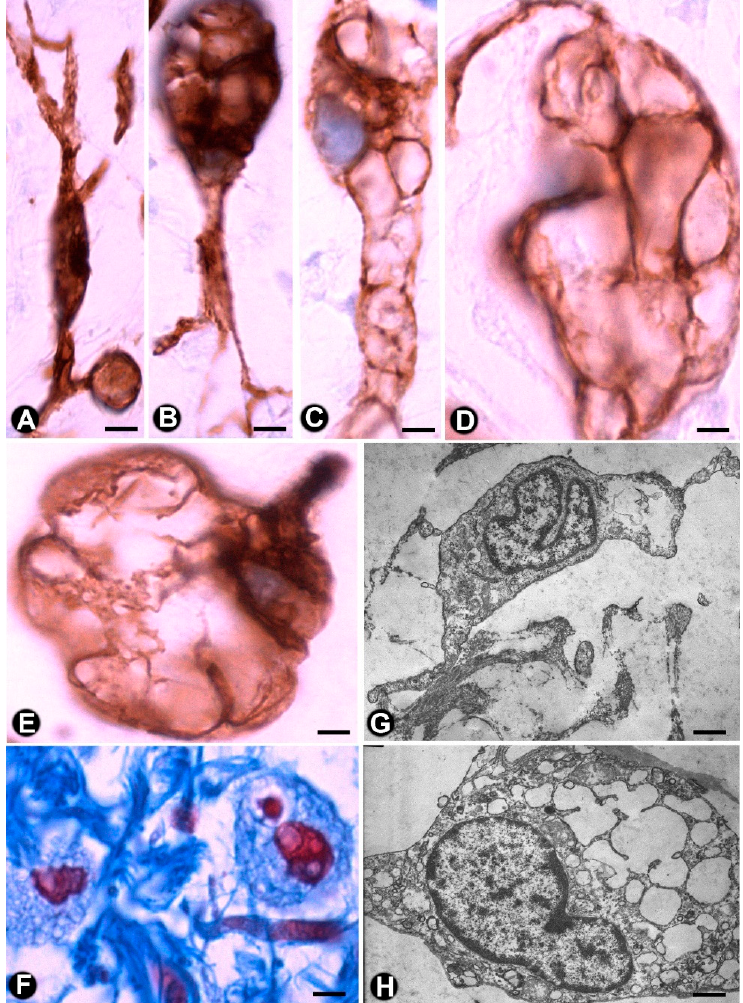
Figure 7. Multi-vacuolated cells (ameboid dendritic cells) in myxoid areas of plexiform neurofibromas. ( A – E ) CD34 expression in the vacuolated cells, which partially retain their primitive fusiform or stellate morphology (A–C) or acquire a globe-like aspect, sometimes with a piriform appearance (D and E). ( F ) Alcian blue positivity in the extracellular matrix and in the vacuolated cells ( G , H ) Ultrastructural characteristics of the cells in the myxoid areas. Note the intracytoplasmic vacuoles and how one cell retains some processes (G), while the other acquires a globoid-like aspect (H). A–E: Anti-CD34 immunostaining. F: Alcian blue staining. G and H: Ultrathin sections. Uranyl acetate and lead citrate. Bar: A-E, 5 µm; F, 10 µm; G, H, 0.5 µm.